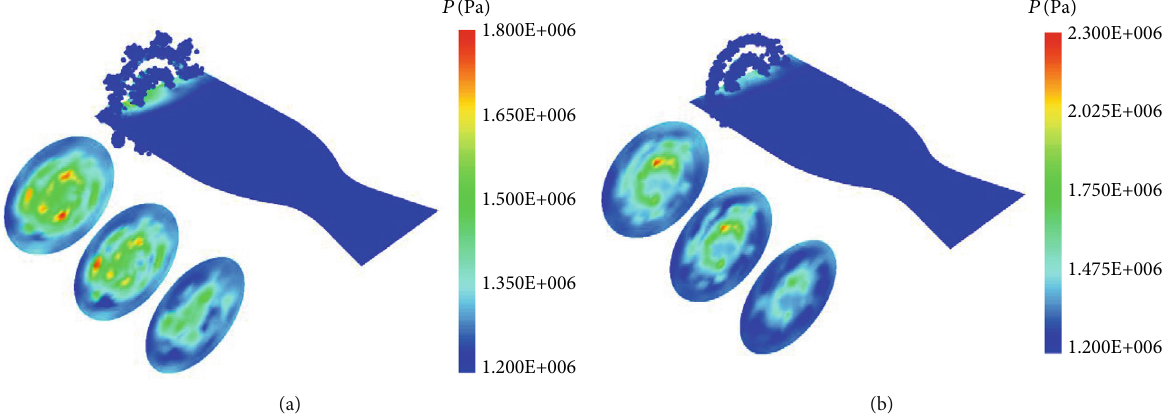
Figure 15: The acoustic pressure contours in Case 3. (a) 8.32259ms, MMH. (b) 9.72029ms,